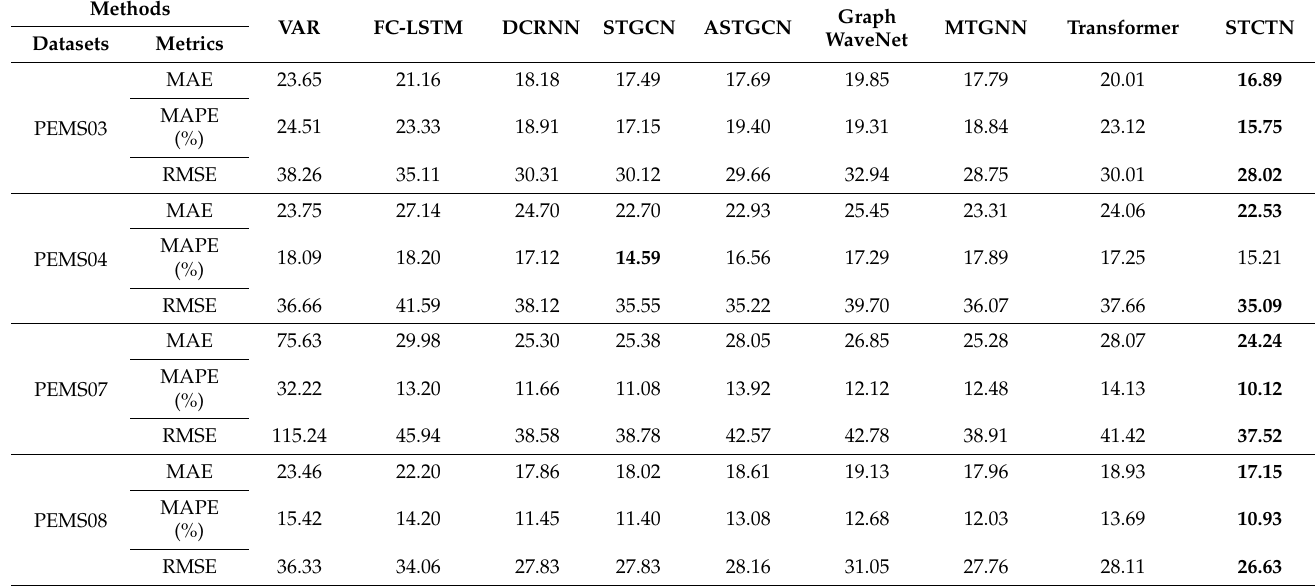
Table 2. Performance comparison of different approaches on datasets with priori graph topology.